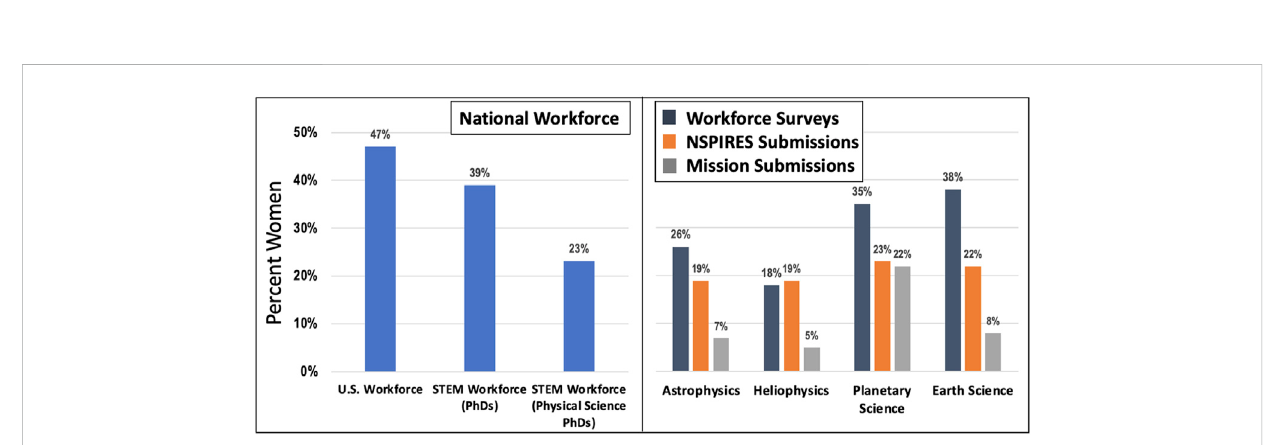
FIGURE 4 Gender statistics of competed mission team leaders compared with the workforce of corresponding NASA SMD divisions and the U.S. STEM workforceoverall.Femalepercentageofpopulations:PIofsubmittedmissionproposals,PIsandCo-IsofNSPIRESproposals,workforceforSMDscience fi elds, U.S. STEM workforce (Physical Science PhDs), U.S. STEM workforce (PhDs in any fi eld), total U.S. workforce. Based on data from Bernard and Cooperdock (2018), National Science Foundation (2019), Pold and Ivie (2018), Porter and Ivie (2019), Porter et al. (2020), and White et al. (2011a),White et al.